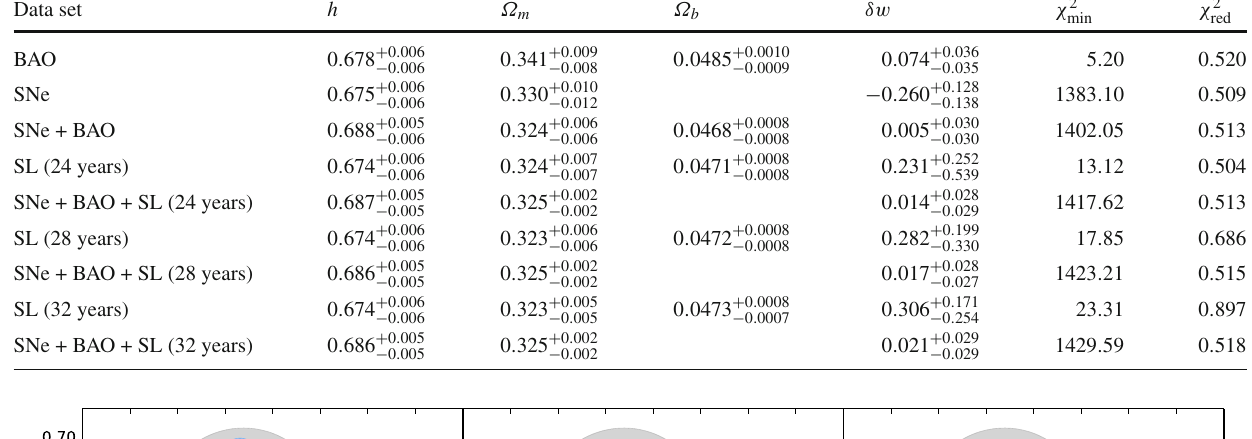
Table 4 Parameter results of the slow-roll model